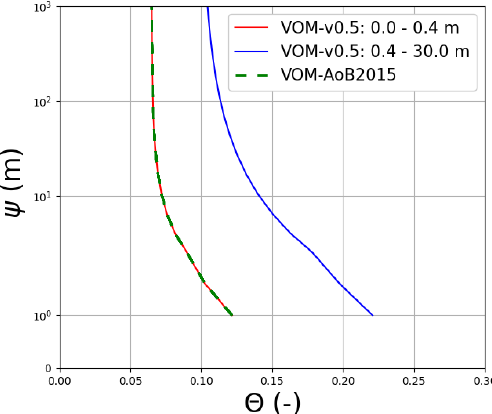
Figure 8. Water retention curves at Howard Springs for the VOM- v0.5 results (red: top two layers, blue: deeper layers) and the results of the VOM-AoB2015 in green. Note that multiple lines are shown for the VOM-v0.5 due to the different soil parameterizations per soil layer in the current model runs, whereas the VOM-AoB2015 used one soil parameterization for all the soil layers. The upper soil lay- ers have however the same soil parameters, leading to overlapping curves (red and dashed